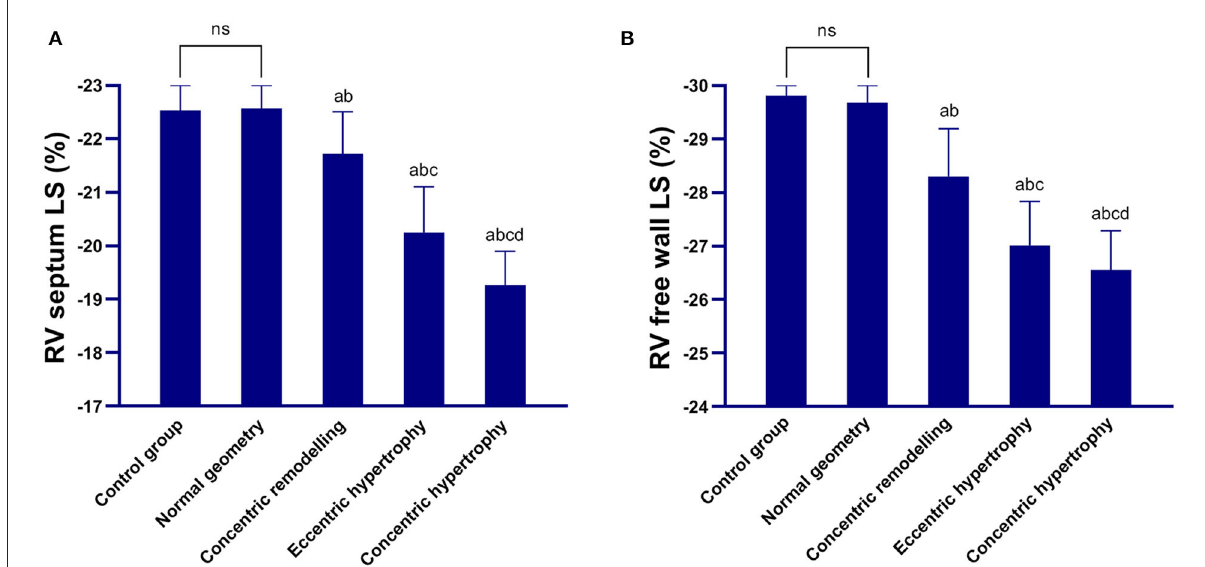
FIGURE1 Comparison between the control group and four geometric pattern groups in terms of the longitudinal strain parameters of the right ventricular myocardium. (A) Right interventricular septum longitudinal strain; (B) Right ventricular free wall longitudinal strain. The right interventricular septum longitudinal strain and right ventricular free wall longitudinal strain decreased in the order of the normal geometric group, concentric remodeling group, eccentric hypertrophy group, and concentric hypertrophy group. ns: there was no significant difference between the control group and the normal geometric group; a: compared with the control group, P < 0.05; b: compared with the normal geometric group, P < 0.05; c: compared with the concentric remodeling group, P < 0.05; and d: compared with the eccentric hypertrophy group, P <